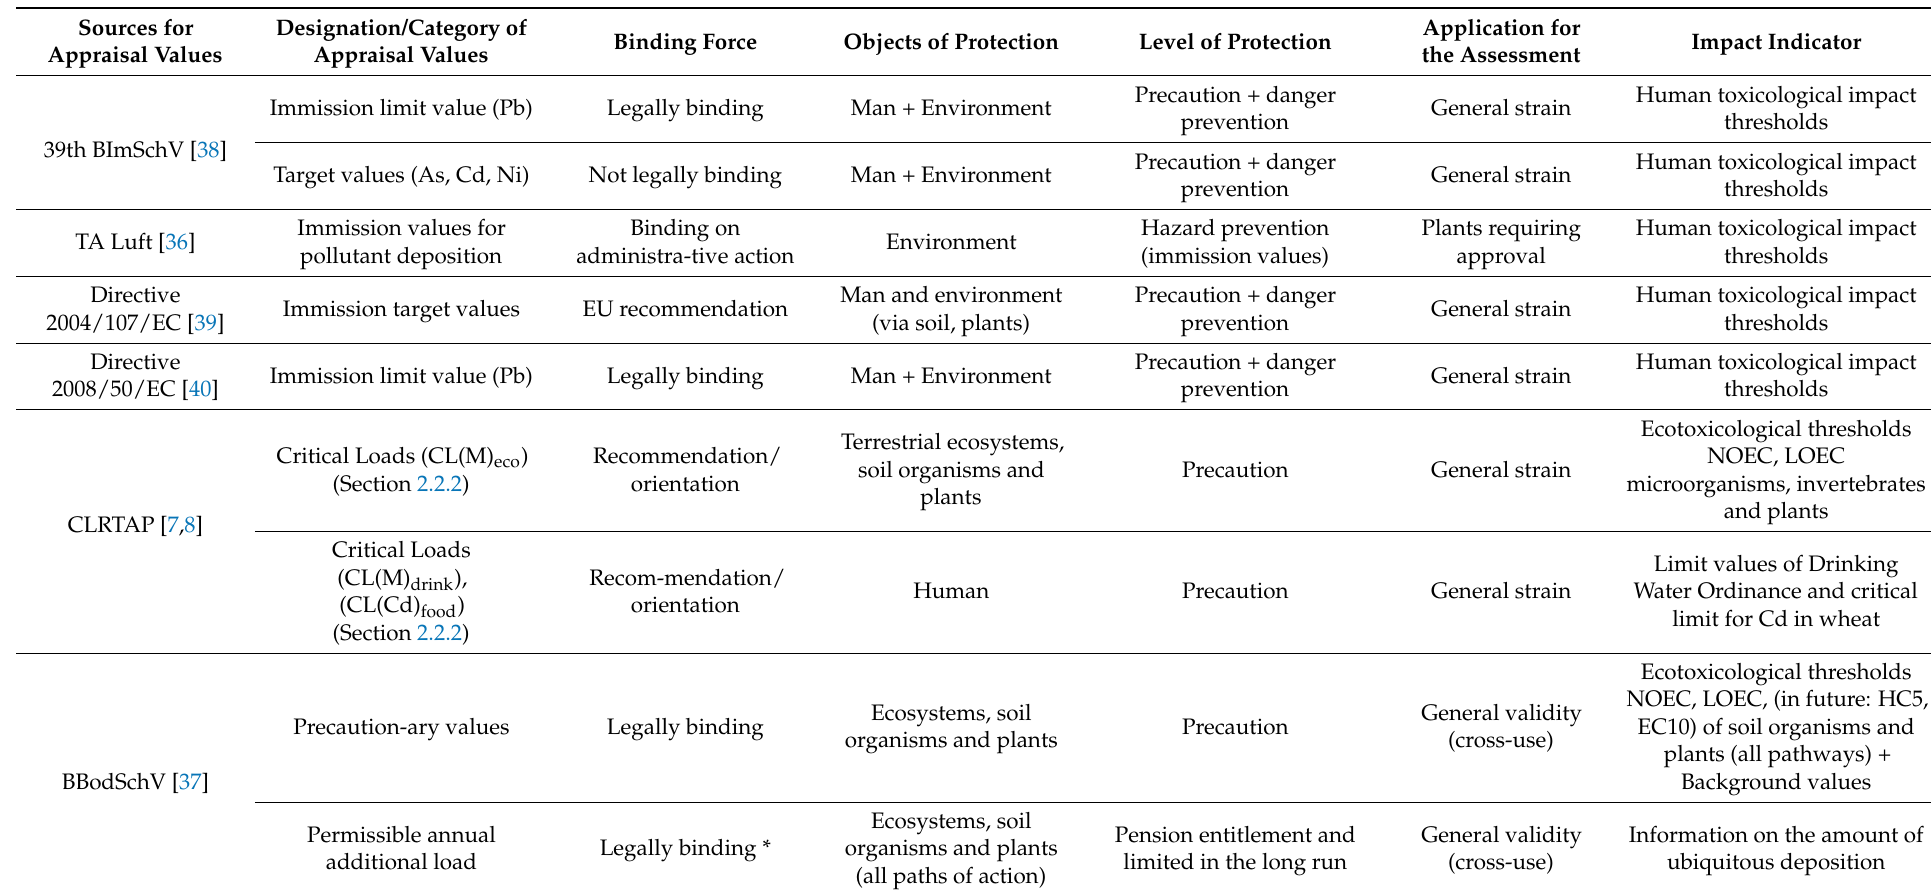
Table 2. Compilation of categories of assessment values from legal, sublegal regulations, and recommendations for air pollution control for heavy metal fluxes for the protection of ecosystems, protected goods, levels and objectives, and impact